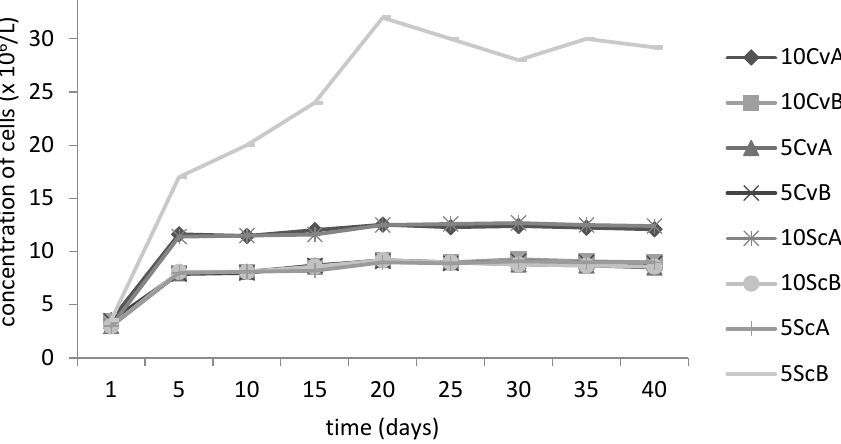
Figure 8. Microscopic images of microalgae immobilized on alginate beads, 400×. Immobilized microalgae cells were less exposed to damage due to the turbulence caused by the mixing process compared to cells slowly suspended in the wastewater so- lution. Before the experiment, the number of microalgal cells immobilized on alginate beads was smaller than after the experiment. Figure 9 shows numerical values of cells of C. vulgaris and S. armatus in wastewater.